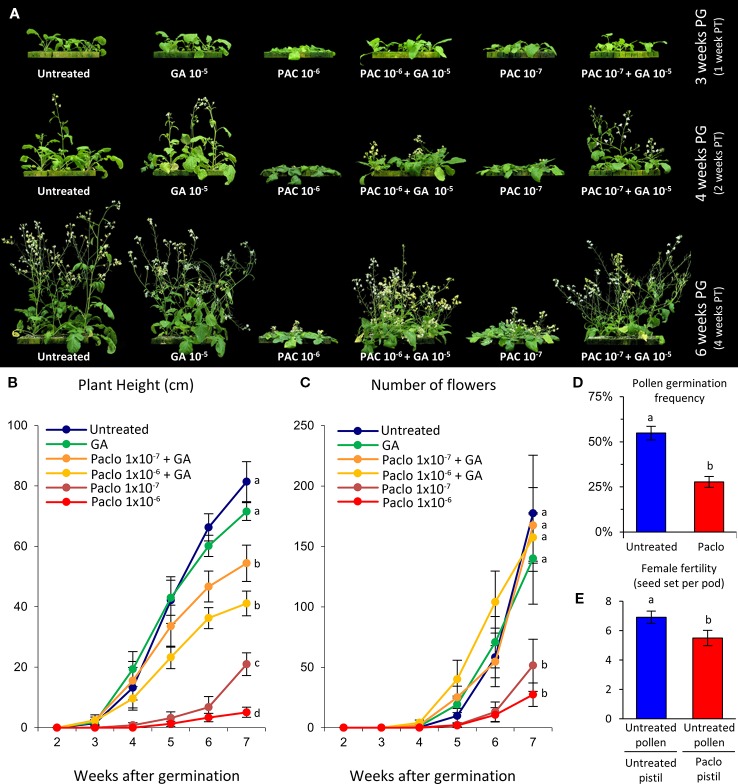
Growth and fertility defects induced by paclobutrazol treatment of hydroponically grown wild radish. (A) Representative images of wild radish showing the impact on growth induced by paclobutrazol (Paclo) treatment. PG, post-germination; PT, post-treatment. (B) Growth, represented as plant height, over a 7 week period. Lettering denotes statistical differences between categories at week 7. (C) Average number of flowers (reproductive units) produced per plant across the different treatments. Lettering denotes statistical differences between categories at week 7. (D)
In vitro pollen germination frequency showing significantly reduced viability of pollen produced by paclobutrazol treated wild radish plants. (E) Reduction in female fertility seen in paclobutrazol treated plants. Pollen (male) donor from PG4 population [mate compatible with Albany (AL) population]. Pistil (female) recipient from untreated and treated AL wild radish plants. Lettering adjacent to data points in panels (B–E) denote pairwise statistical comparison between categories. Categories marked with a given letter are statistically different from categories marked with another letter (Student’s t-test p < 0.05). All error bars are S.E.M. N = (B, C) 10 plants for each treatment; (D) 10 anthers, 1 anther from 10 independent flowers; (E) 20 siliques.